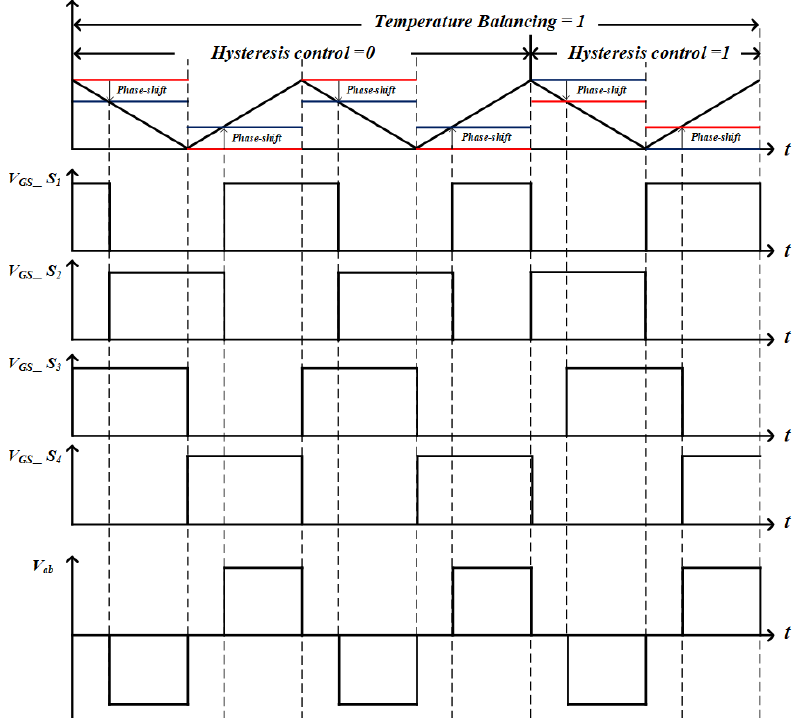
Figure 6. Operational waveforms based on the temperature-balancing signal changes in the PSFB converter.